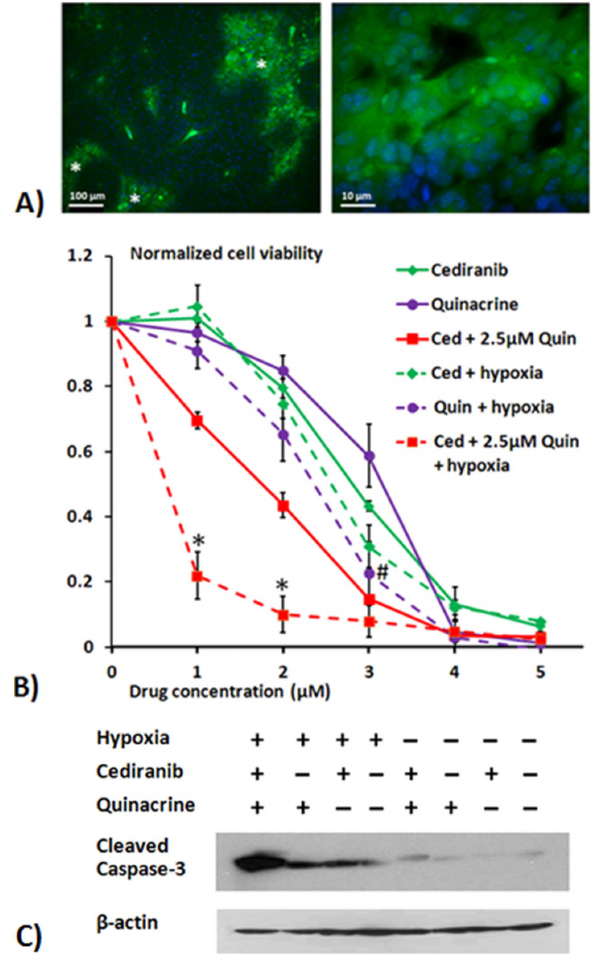
Fig. 1. Hypoxia’s presence in vivo and its effect on cediranib/quinacrine efficacy in vitro . A) Representative tumor sections showing immunohistochemical detection of hypoxic regions in 4C8 glioma, shown under low (left panel) and high (right panel) magnification. Sections were obtained from 3 mice, 2 weeks post initiation of tumor growth. Hypoxic cells were identified using Alexa488 labeled anti-EF5 antibody (green). Nuclei were stained with DAPI (blue). Regions marked with * denote positive staining for hypoxia in the low magnification image. B) Results from MTS cell viability assays showing mean 4C8 cell viability in response to treatment with cediranib and/or quinacrine, normalized to untreated samples. Assays were performed after cells were exposed to treatment for 72 hours, under normoxic or hypoxic (0.5% O 2 ) conditions. Results are mean ¡ SEM of three independent experiments, performed in triplicate. Significant differences between tumor cell viability results under hypoxic and normoxic are denoted by # (p , 0.05) for single agent quinacrine treatment and * (p , 0.05) for cediranib/quinacrine combination treatment. C) Representative cleaved caspase-3 western blots obtained from 4C8 cells grown under normoxic or hypoxic conditions for 72 hrs while untreated or exposed to cediranib (2 m M), quinacrine (2 m M), or combined